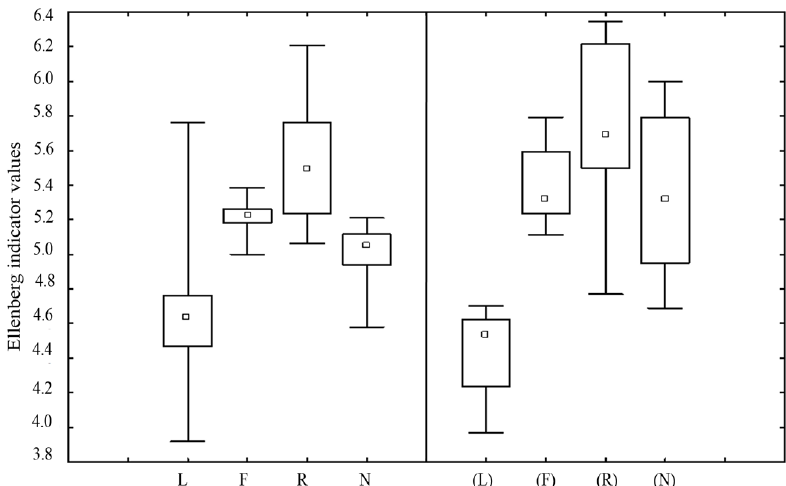
The comparison of box plot distributions of Ellenberg indicators points to a decrease and lower variability of light (L) values, as well as to an increase of indicator values and the variability connected to soil conditions (soil moisture (F), soil reaction (R), and nitrogen content (N). Their variability increased, particularly in the case of soil moisture and nitrogen content indicators. In the past, light conditions showed the greatest variability; however, at present, that is found in the soil reaction and nitrogen content of the soil (Figure 3).